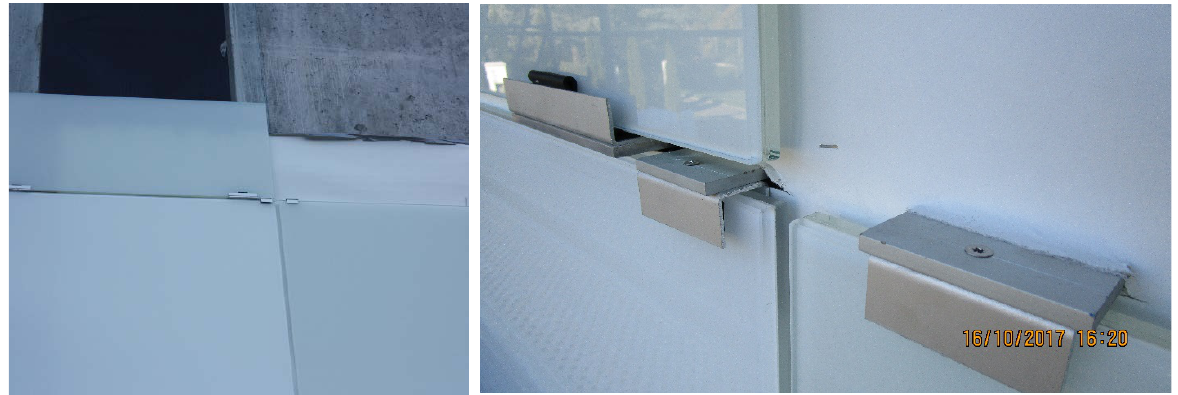
Fig. 9: Detail of colors of the different proposed